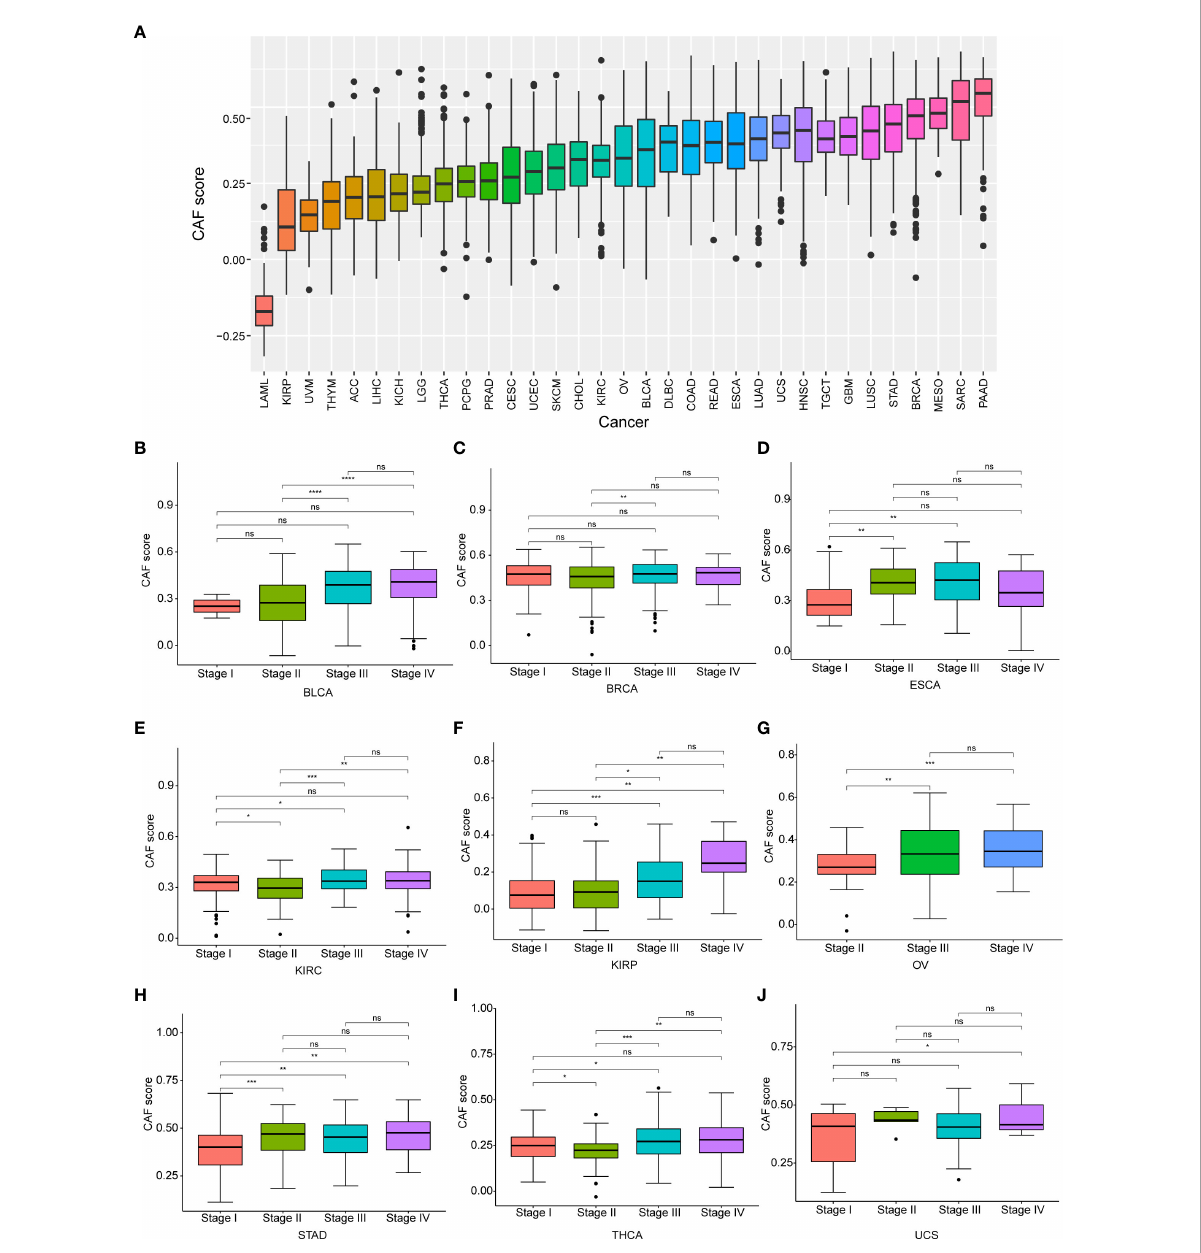
FIGURE 3 The differential distribution of CAF score. (A) The CAF score distribution in pan-cancer. (B) The differential distribution of CAF score in various tumor stages in pan-cancer. Only signi fi cant results were shown. *p < 0.05, **p < 0.01, ***p < 0.001, ****p <